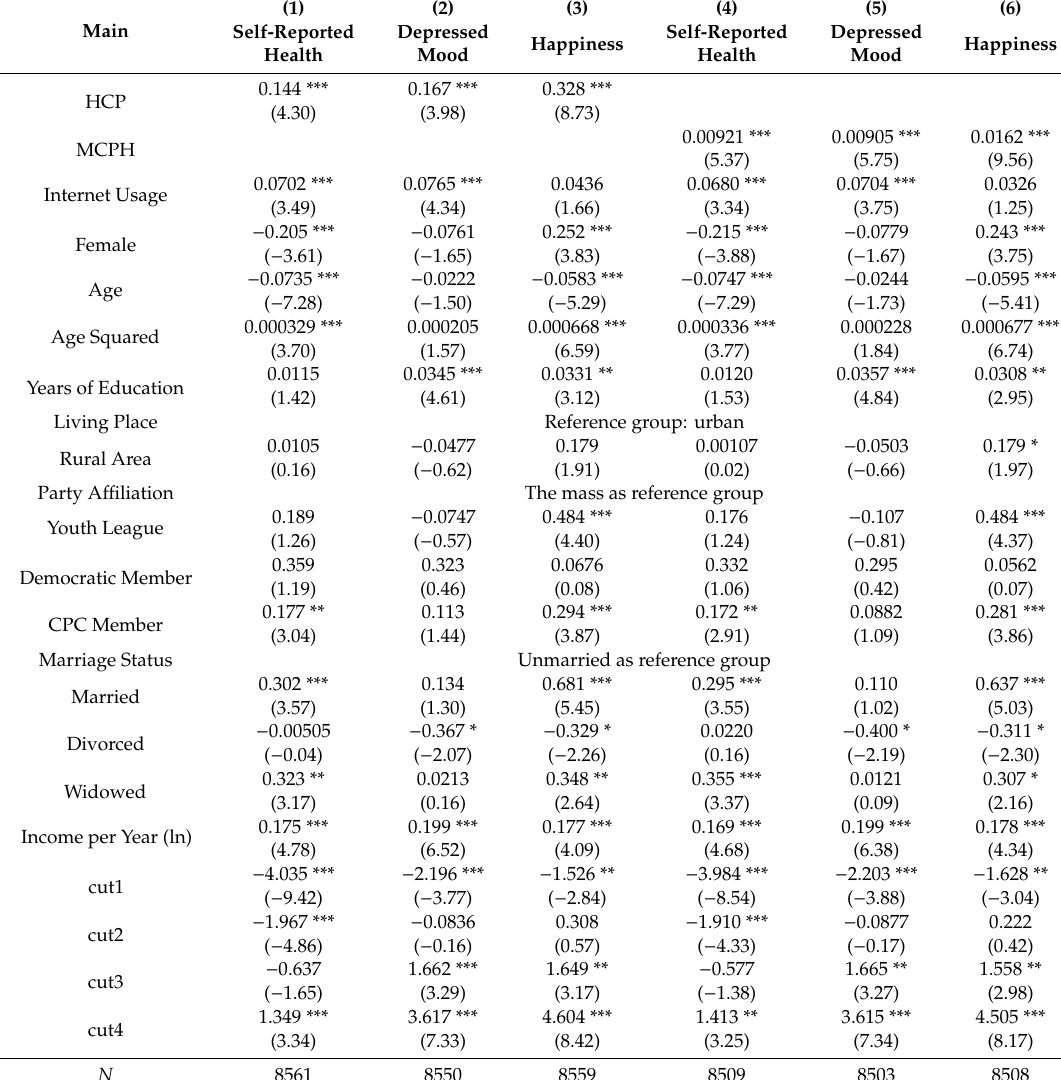
Table 2. Ordered logit model regression